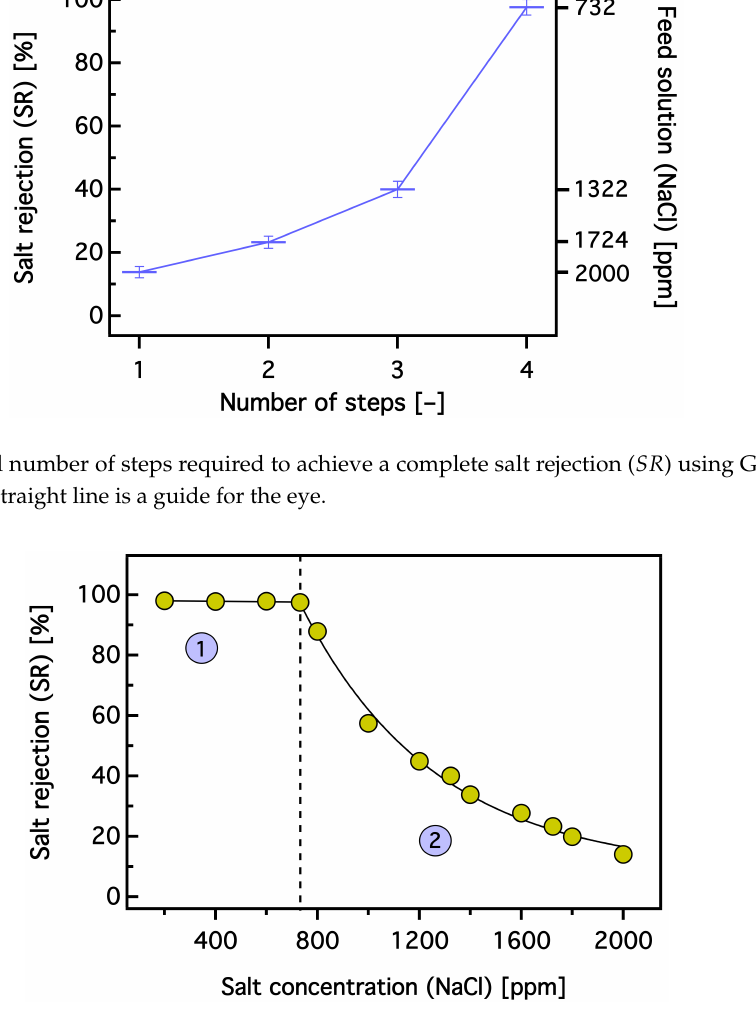
Figure 17. The influence of the salt concentration in the feed solution on the salt rejection, using a GG10k–30 hydrogel. The straight lines are linear and exponential fits to the data in the regime 1 and 2,